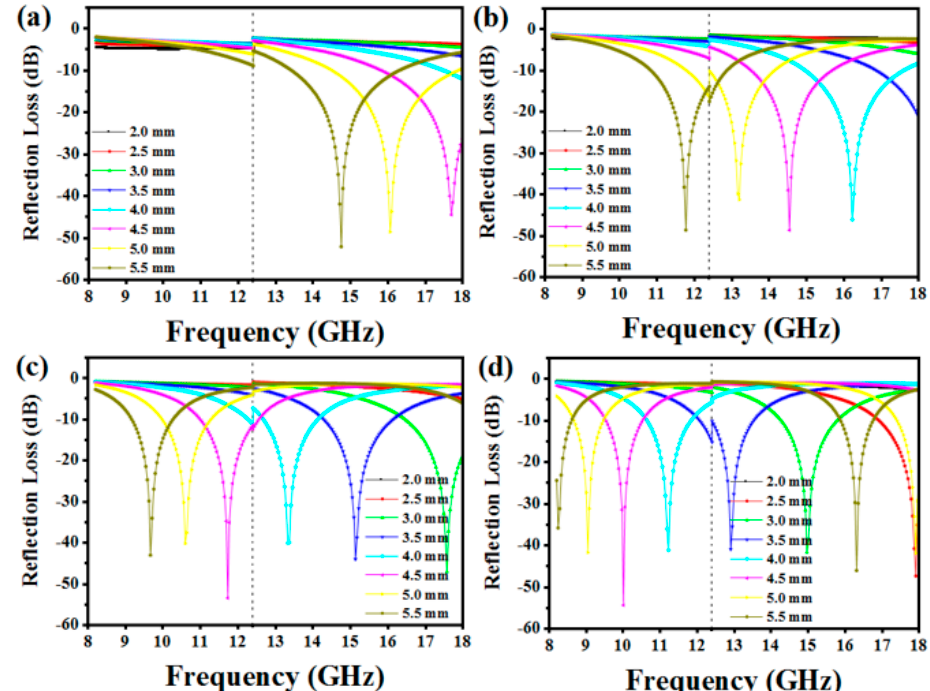
Figure 10. RL curves for ( a ) M0, ( b ) M10, ( c) M20, and ( d ) M40 with different thickness at x-band (8.2–12.4 GHz) and Ku-band (12.4–18 GHz) frequency. Table 1. MAP of some Fe 3 O 4 -based composites reported in previous references and this work.